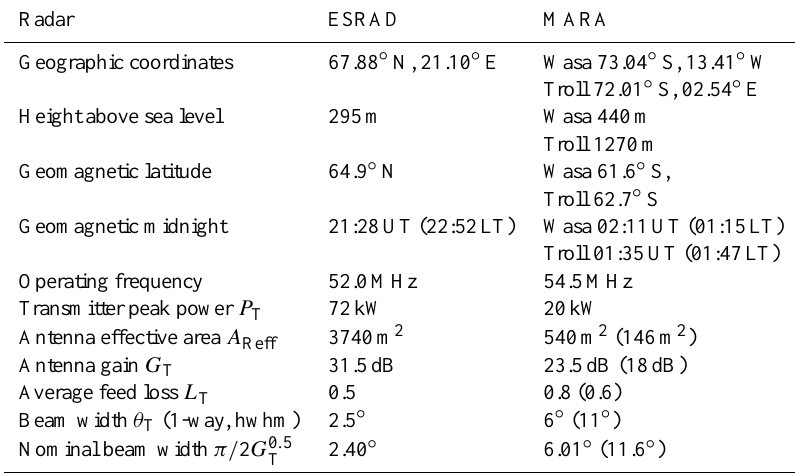
Table 1. Main characteristics of the radars used in this study. Geomagnetic coordinates are calculated using the online facility provided by Papitashvili (2012). Antenna effective area A Reff , gain G T and beam width θ T are calculated on the basis of the dimensions and spacing of the antenna elements. Antenna parameters in parentheses applied during November and December